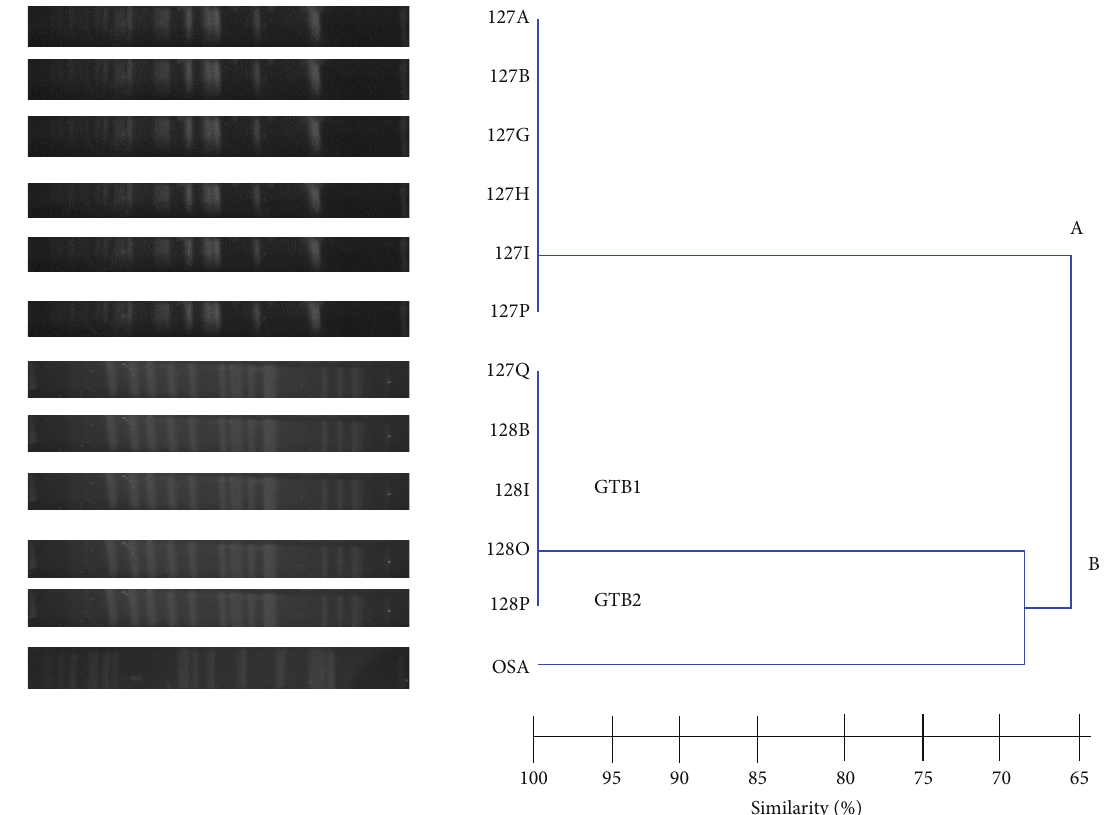
Figure 1: Fingerprints and dendrogram obtained by PFGE of twelve Salmonella isolates in this study. GT, genomic type. Six S. Newport (127A, B, G, H, I, and P), and one S. Gaminara (127Q) isolates from a tonsil, and four S. Gaminara (128B, I, O, and P) isolates from tongue of the same wild boar. S. Typhimurium strain of human origin